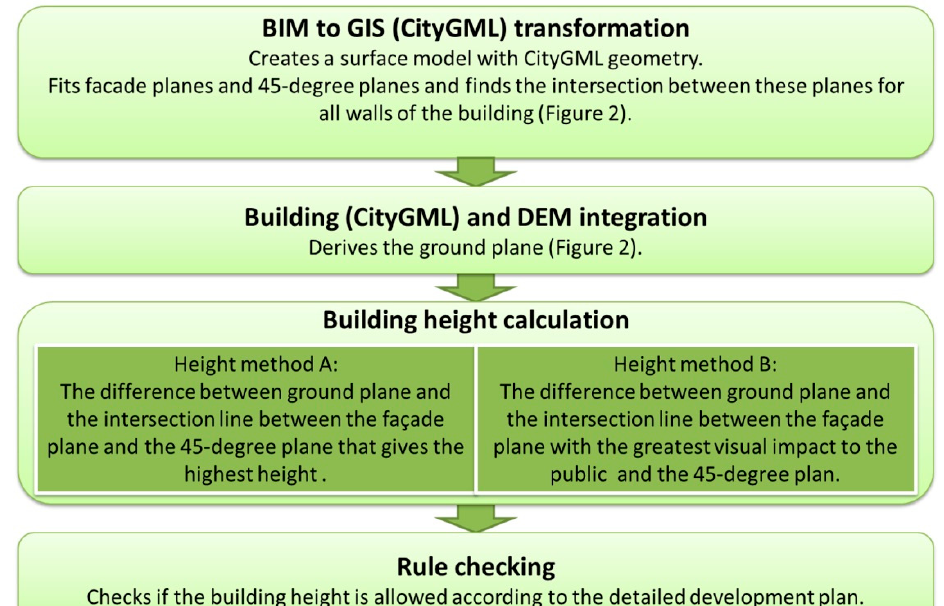
Figure 3. Workflow of the building height calculation.